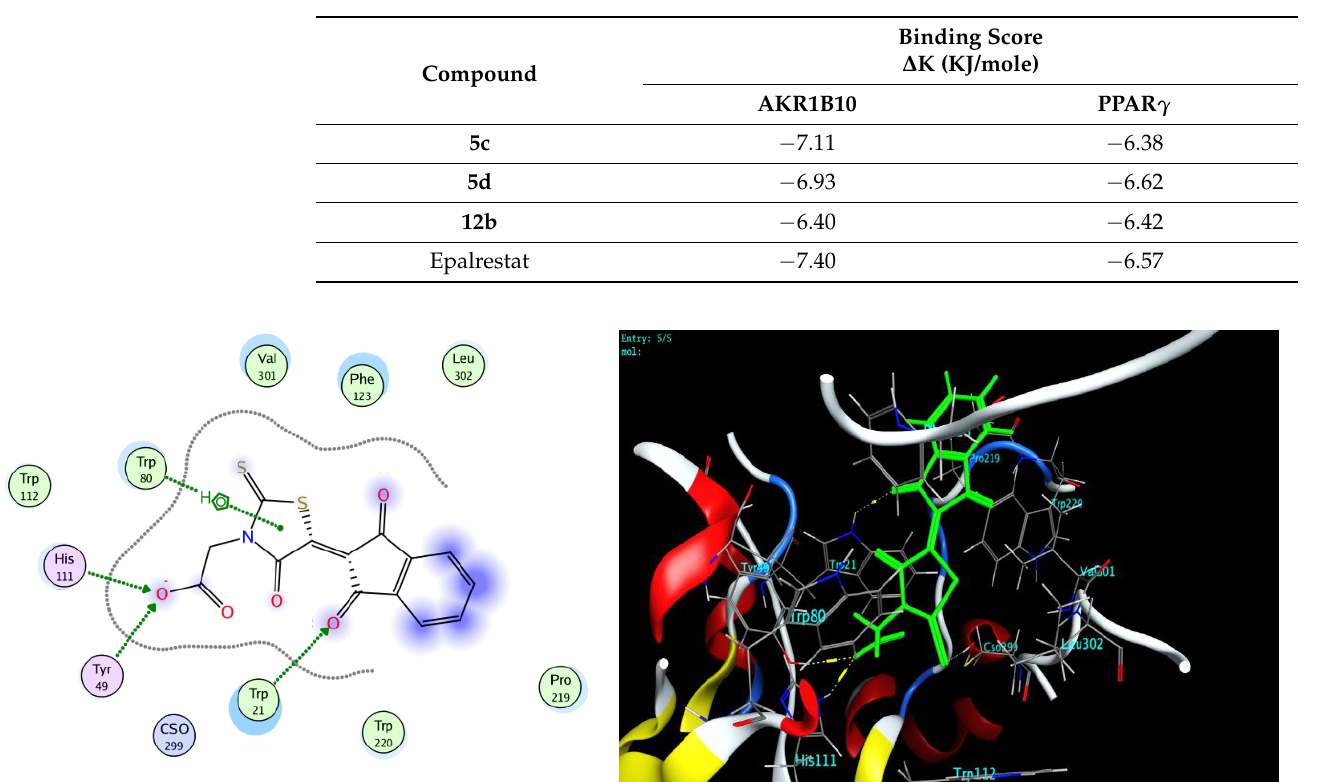
Figure 4. 2D and 3D docking of compound 5c with AKR1B10.